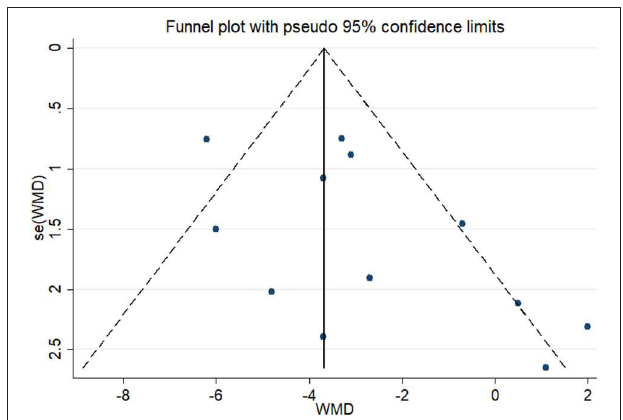
FIGURE 3 | Funnel plot for publication